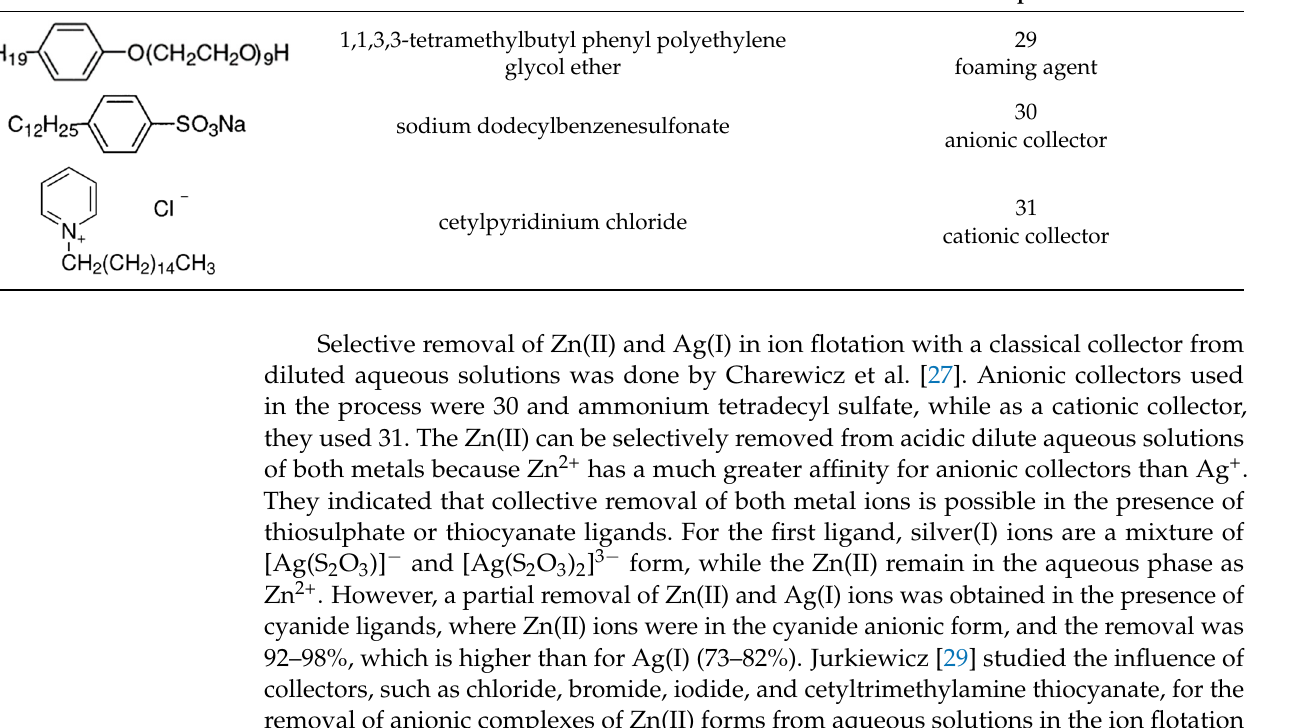
Table 2. Additional compounds used in Zn(II) and Cd(II) ions flotation in the quoted works [26–28]. Structural Formula